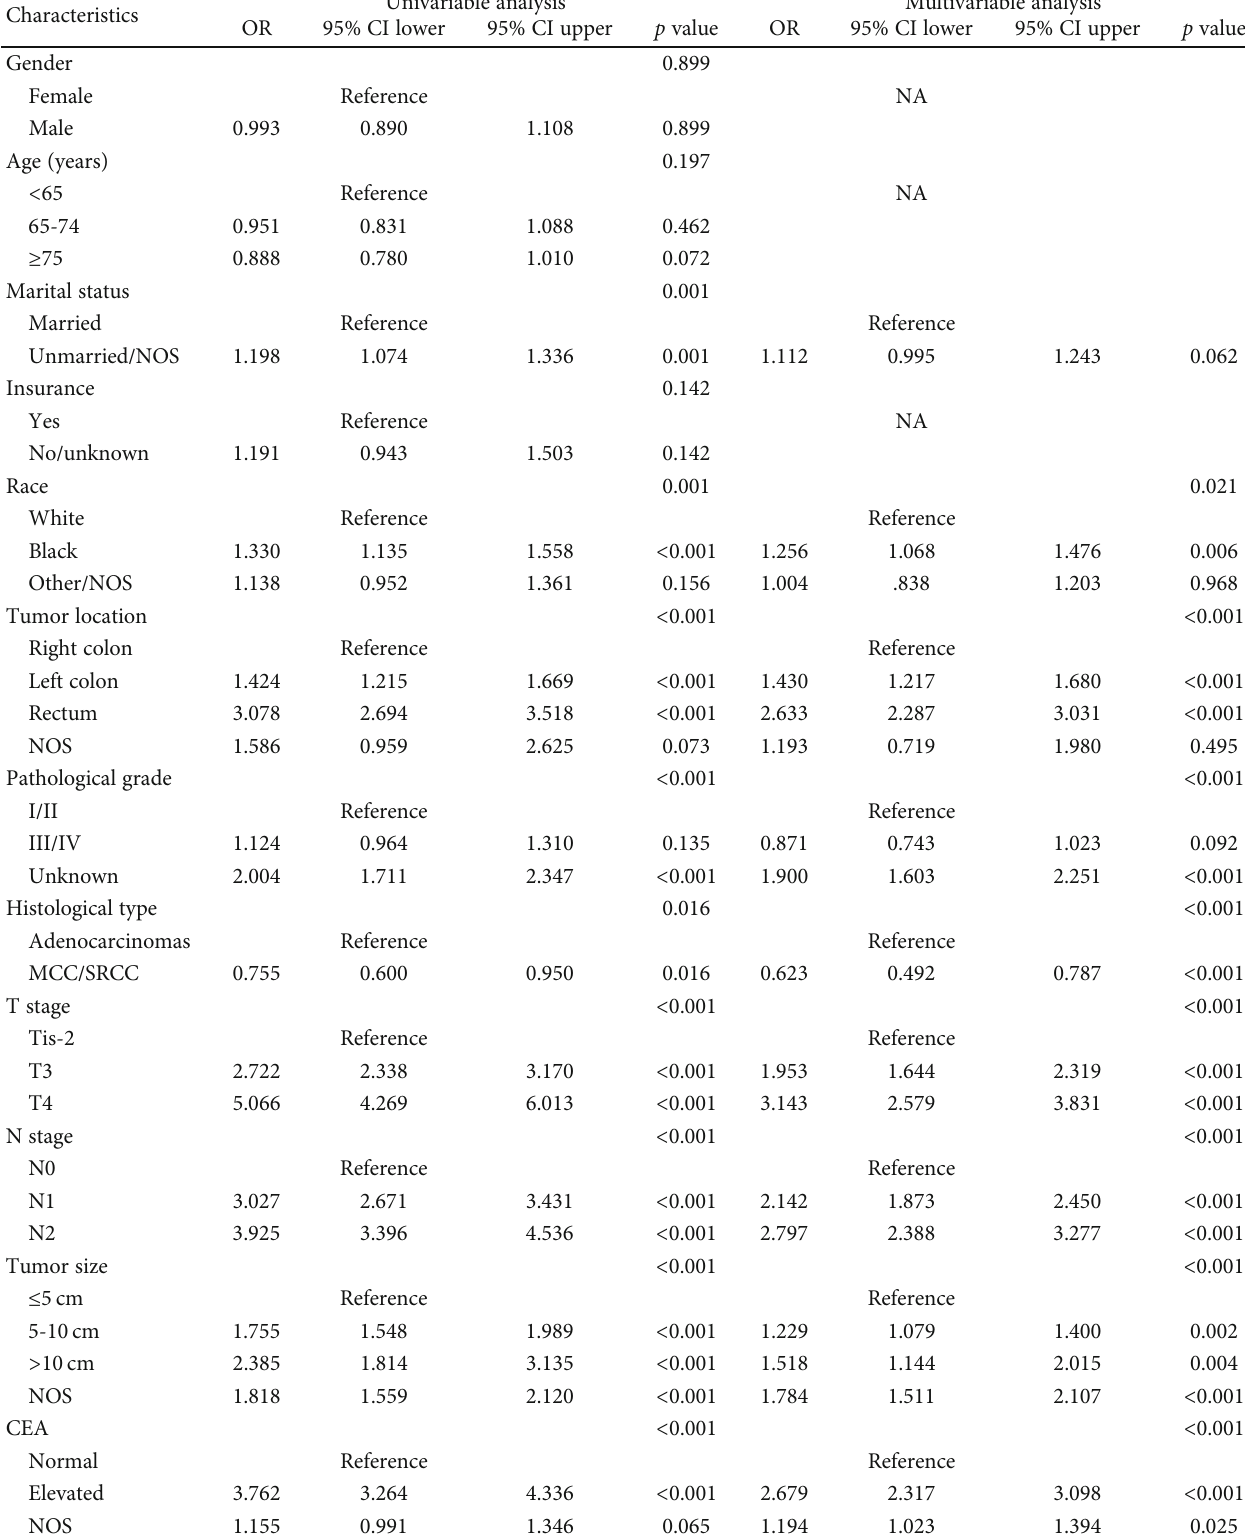
Table 2: Univariable and multivariable logistic regression model